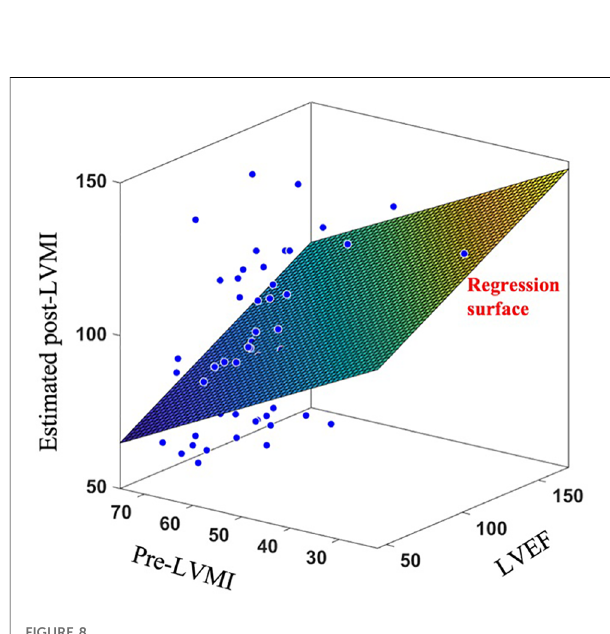
FIGURE 7 Predicted outcomes (vertical axis) vs clinically reported outcomes (horizontal axis) for train data (blue circles) and test data (red crosses). LVMI: Left ventricle mass